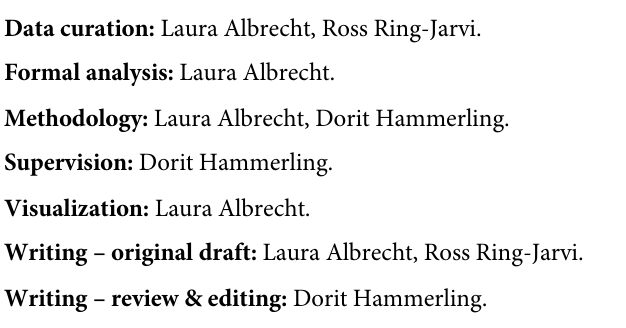
change much between the 18–34, 35–39, and 40–44 age groups. We then see a shift towards slower times in each subsequent age group, particularly in the oldest age groups. (TIF) S3 Fig. Percentage of women runners by age group from 2000–2019. The 18–34 age group increased towards 50% and then appears to have leveled off around that 50% split. All other age groups are increasing on average each year. We observe a sharper increase in the percent- age of Women in many age groups in 2012 due to New York not being held that year. New York has a lower percentage of women runners than most other marathons so it’s exclusion leads to the spike observed. (TIF) S1 Table. Number of participants by marathon and age group. (PDF) S2 Table. Cut-off times and average number of participants by marathon. Differences in cut-off times may be responsible for the variation in the proportion of qualifiers across differ- ent marathons. Also, each marathon has different levels of enforcement with cut-off times which could impact the distribution of finishers.